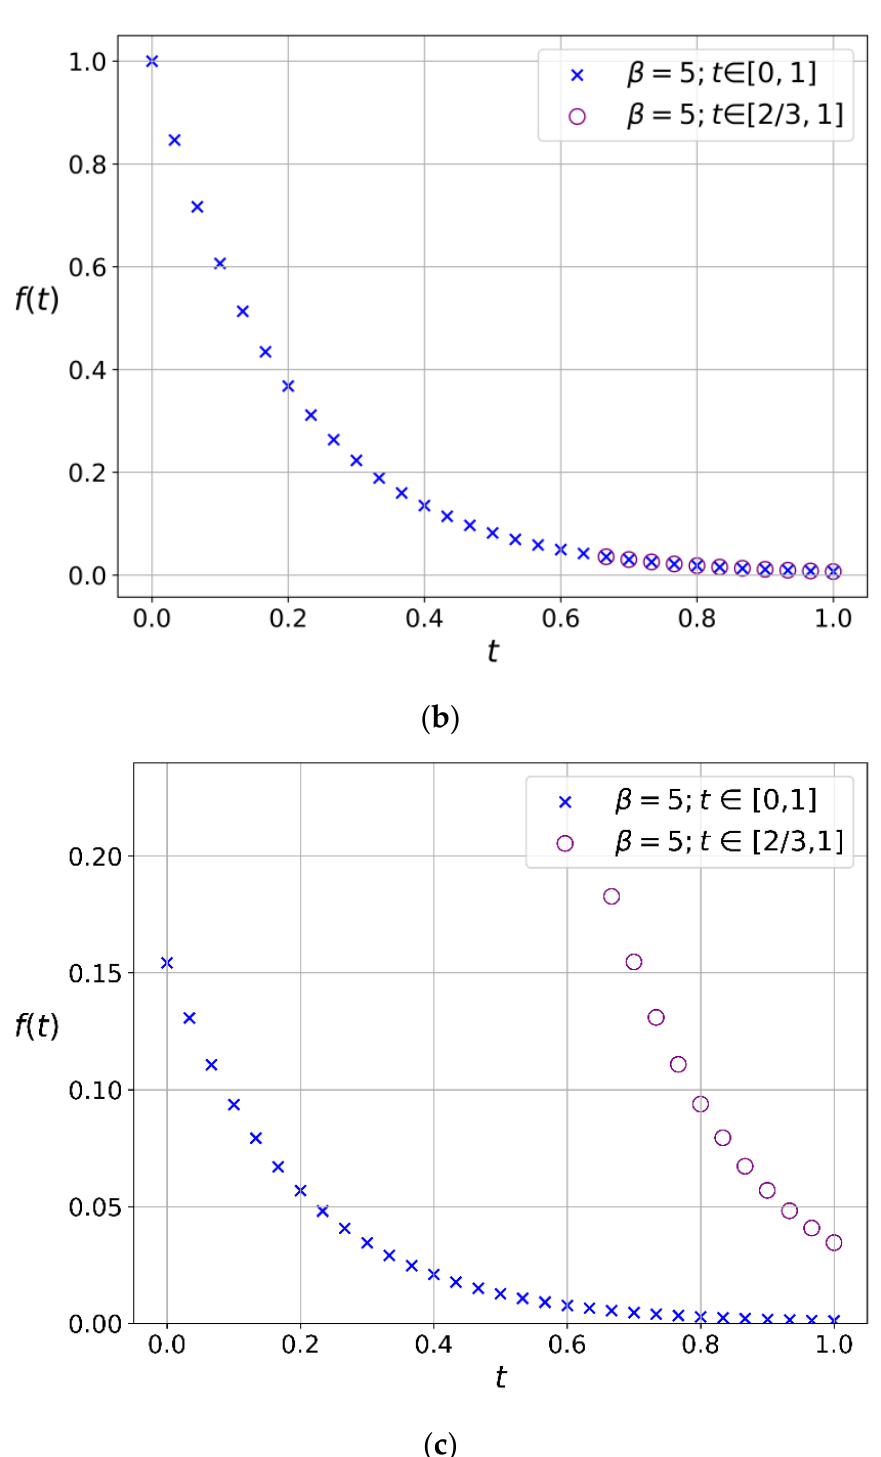
Figure 6. Attenuation function: ( a ) different β values; ( b ) different intervals [0, 1] and [2/3, 1]; ( c ) normalization.